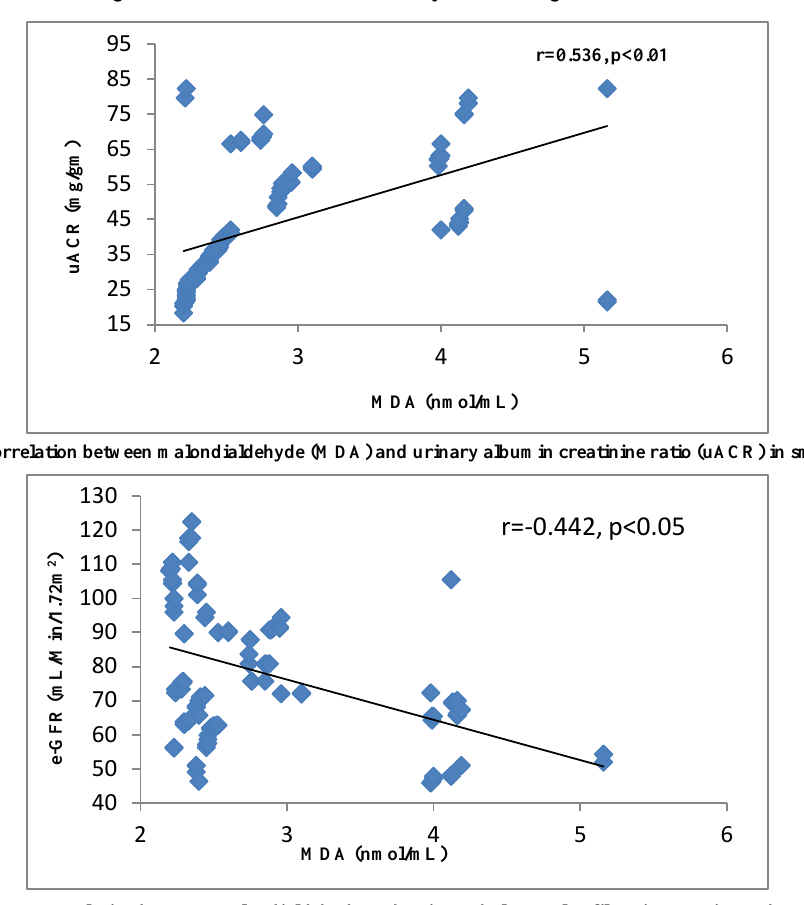
Fig. 3. Correlation between malondialdehyde and estimated glomerular filtration rate in